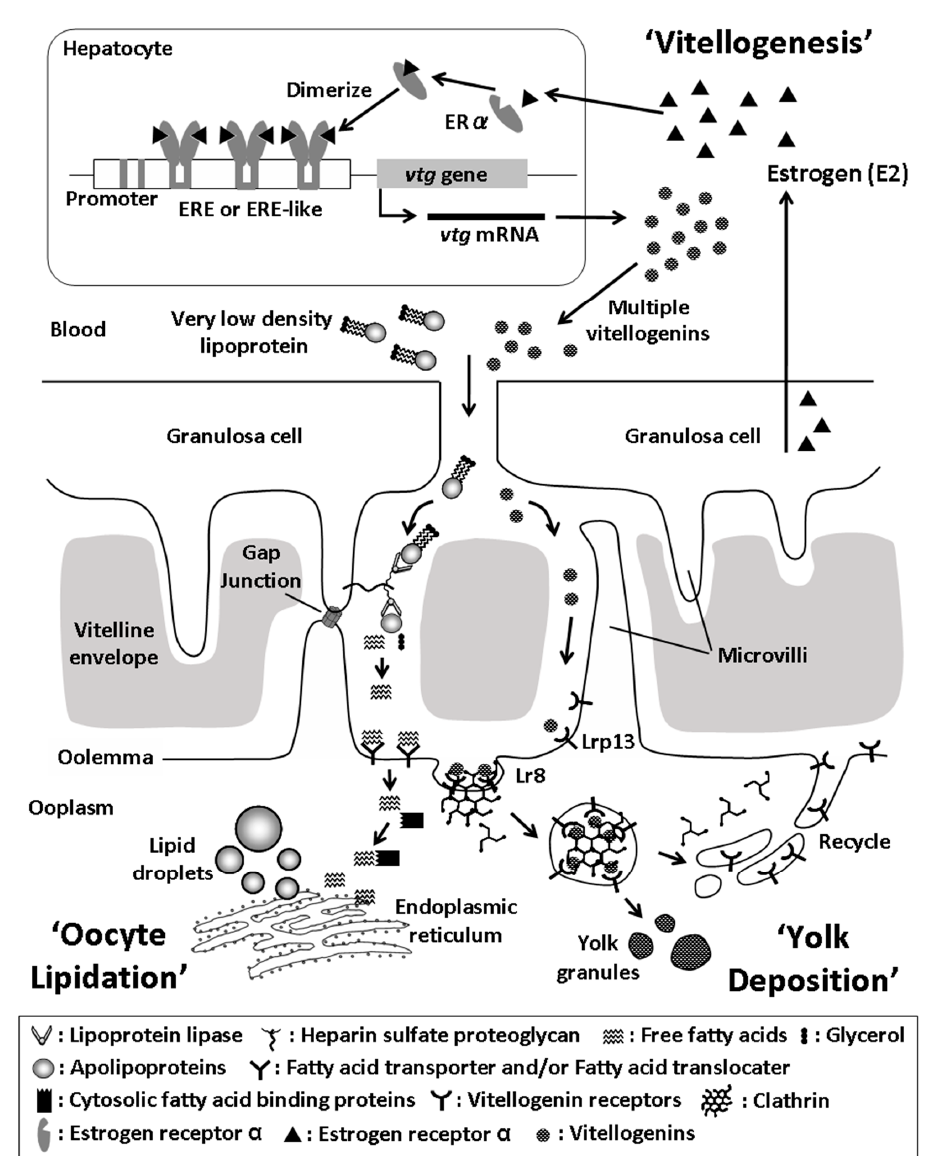
Figure 2. Model of oogenesis depicting ‘Oocyte Lipidation’, which occurs during previtellogenesis and ‘Yolk Deposition’, which occurs during ‘Vitellogenesis’. Circulating very low density lipoprotein is processed by lipoprotein lipase anchored to heparin sulfate proteoglycan within the ovarian follicle cell layer. Free fatty acids then cross over the oolemma escorted by fatty acid transporter and/or fatty acid translocator proteins where they are transferred to the endoplasmic reticulum by cytosolic fatty acid binding proteins located in the ooplasm. Free fatty acids are then re-esterfied and stored within lipid droplets or inclusions located throughout the ooplasm (Oocyte Lipidation). Estrogen (E2) produced by the ovarian follicle granulosa circulates to the liver where it enters into hepatocytes and binds an estrogen receptor. The estrogen receptors dimerize and bind estrogen response elements (EREs) or ERE-like sequences in the gene promoter regions to initiate transcription of multiple types of vitellogenins (Vitellogenesis). Vitellogenin gene transcripts are translated and mature particles are secreted into the blood where they travel to the ovary and bind specific membrane vitellogenin receptors (Lr8 and Lrp13). Vitellogenin receptors cluster into clathrin coated vesicles that are endocytosed and vitellogenins are processed into yolk proteins for storage in yolk granules located throughout the ooplasm (Yolk Deposition). The figure summarizes data from: [5–22,25,28–31,134].